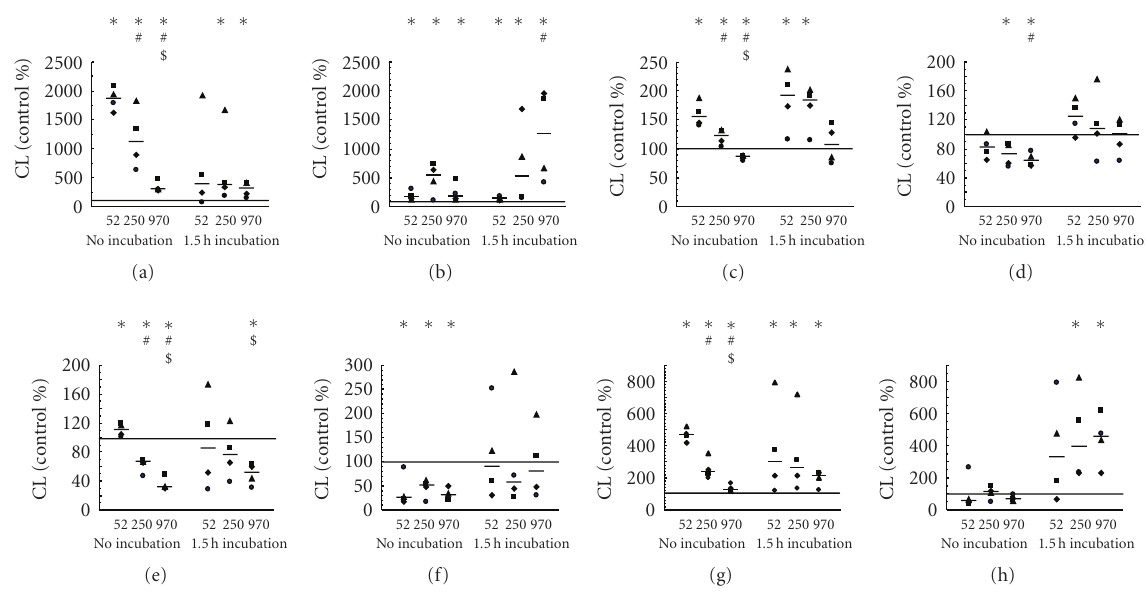
Figure 2: E ff ect of di ff erent MW HA (100 μ g/mL) on spontaneous (a, b), PMA-activated (c, d), OZP-activated (e, f), and starch-activated (g, h) ROS production measured in diluted whole blood by luminol-enhanced chemiluminescence in absence (a, c, e, g) and presence of collagen (0.16mg/mL) (b, d, f, h), immediately or after 1.5 h pre-incubation after addition of HA. The bold line represents the median, and data points from parallel measurements are presented by the same symbol. Statistically significant di ff erences among di ff erent groups ( P < . 05) are marked by di ff erent symbols: ( ∗ ) statistical significance to control, (#) statistical significance to sample incubated with 52kDa HA, and ($) statistical significance between samples incubated with 250kDa and 970kDa HA.